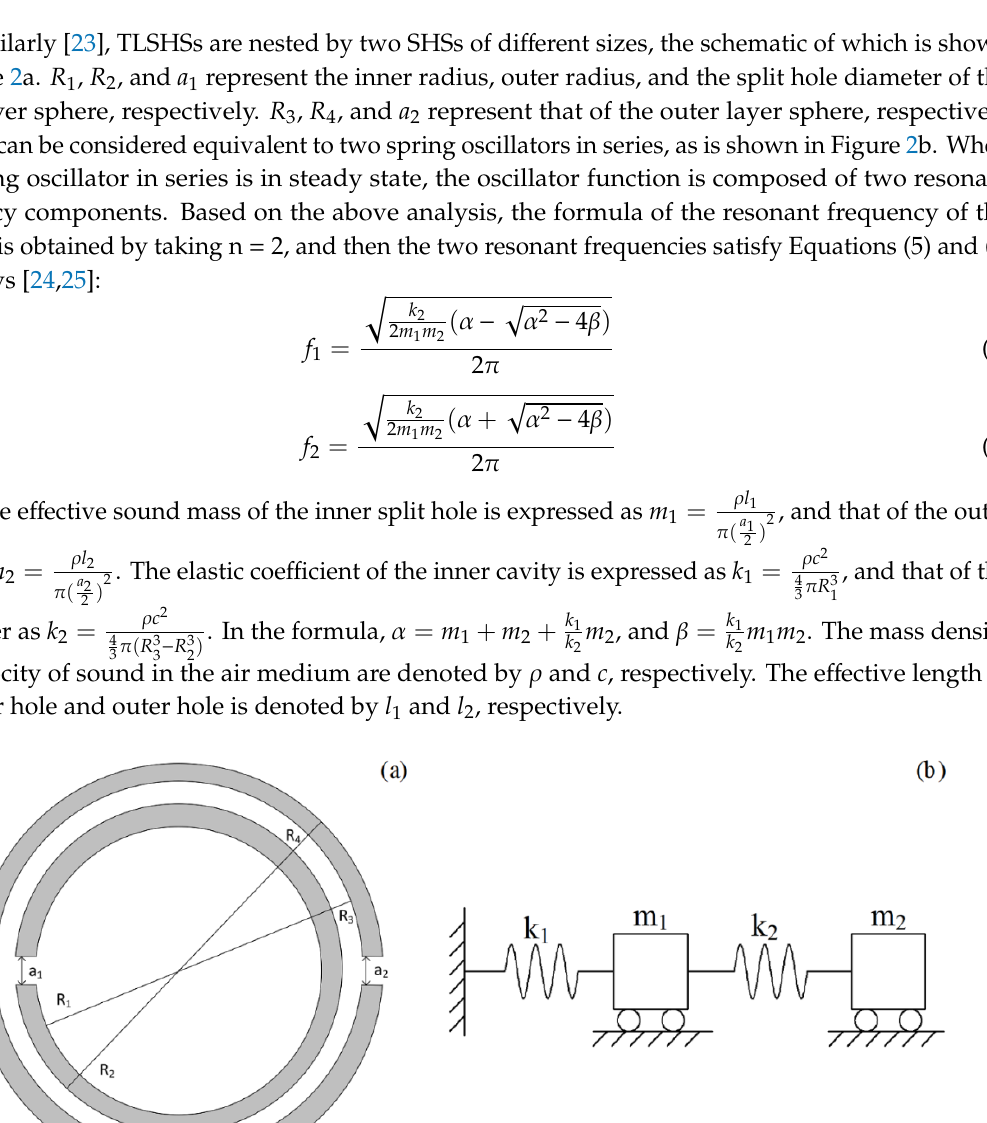
Figure 1. ( a ) The cross section of multilayer split hollow spheres (MLSHSs). ( b ) Schematic diagram of multiple spring oscillators in series.